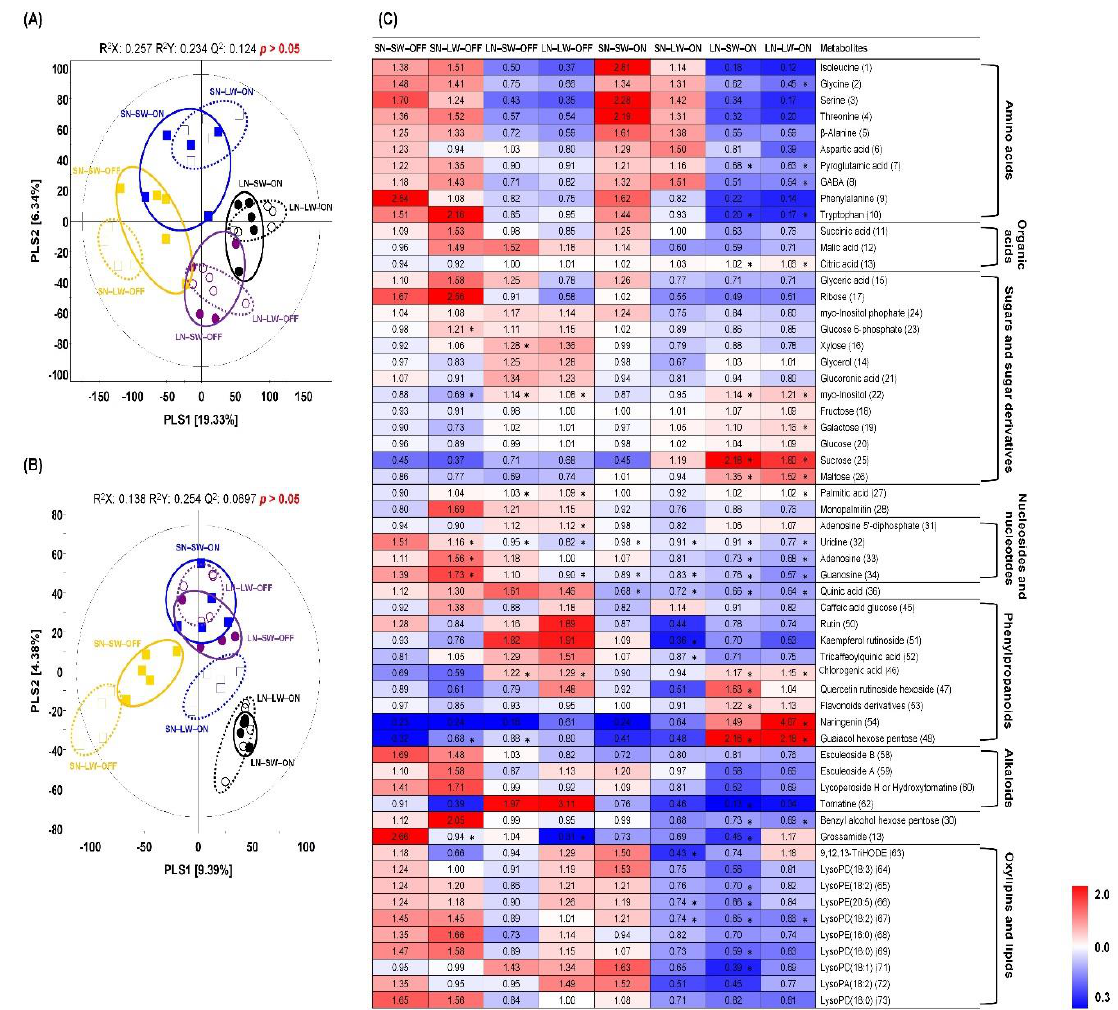
Figure 2. PLS-DA score plots from GC-TOF-MS ( A ) and UHPLC-LTQ-Orbitrap-MS ( B ) analysis of tomato cultivated under different nutrient, water, and light condition. Symbol, SN-SW-OFF ( ■ ); SN-LW-OFF ( □ ); LN-SW-OFF ( ● ); LN-LW-OFF ( ○ ); SN-SW-ON ( ■ ); SN-LW-ON ( □ ); LN-SW-ON ( ● ); LN-LW-ON ( ○ ). SN, standard N; SW, sufficient water; OFF, red light off; LN, Low N; LW, limited water; ON, red light on. Heat map analysis for the relative abundance of discriminant metabolites (VIP > 1.0) based on GC-TOF-MS and UHPLC-LTQ-Orbitrap-MS datasets ( C ). The colored squares (blue to red) indicate fold changes normalized by the average of each metabolite. * Significantly difference metabolite from control (SN-SW-OFF) evaluated by t -test ( p < 0.05).